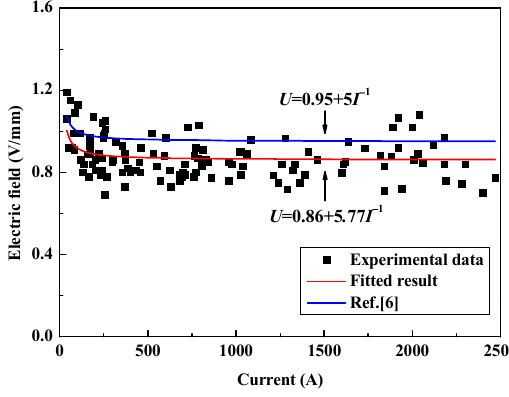
Figure 9. E-I characteristic of long free burning arc.